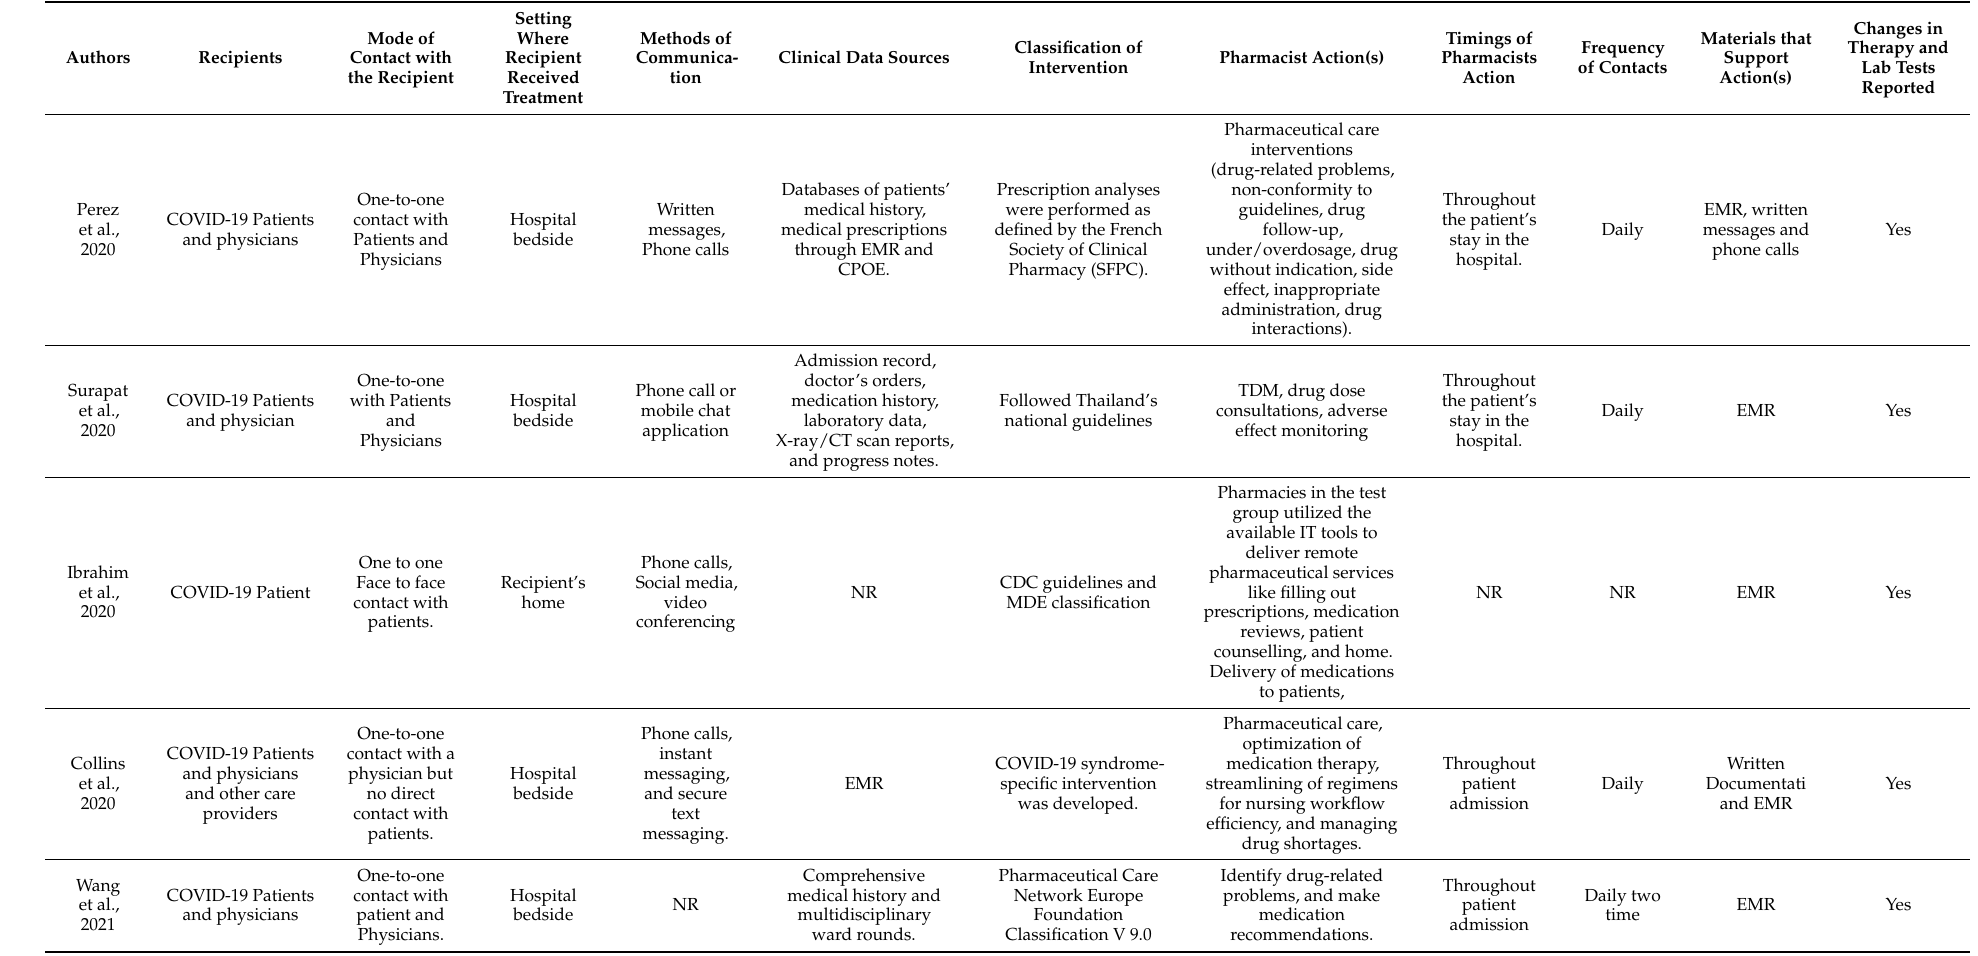
Table 2. Description of pharmacist intervention according to DEPICT version